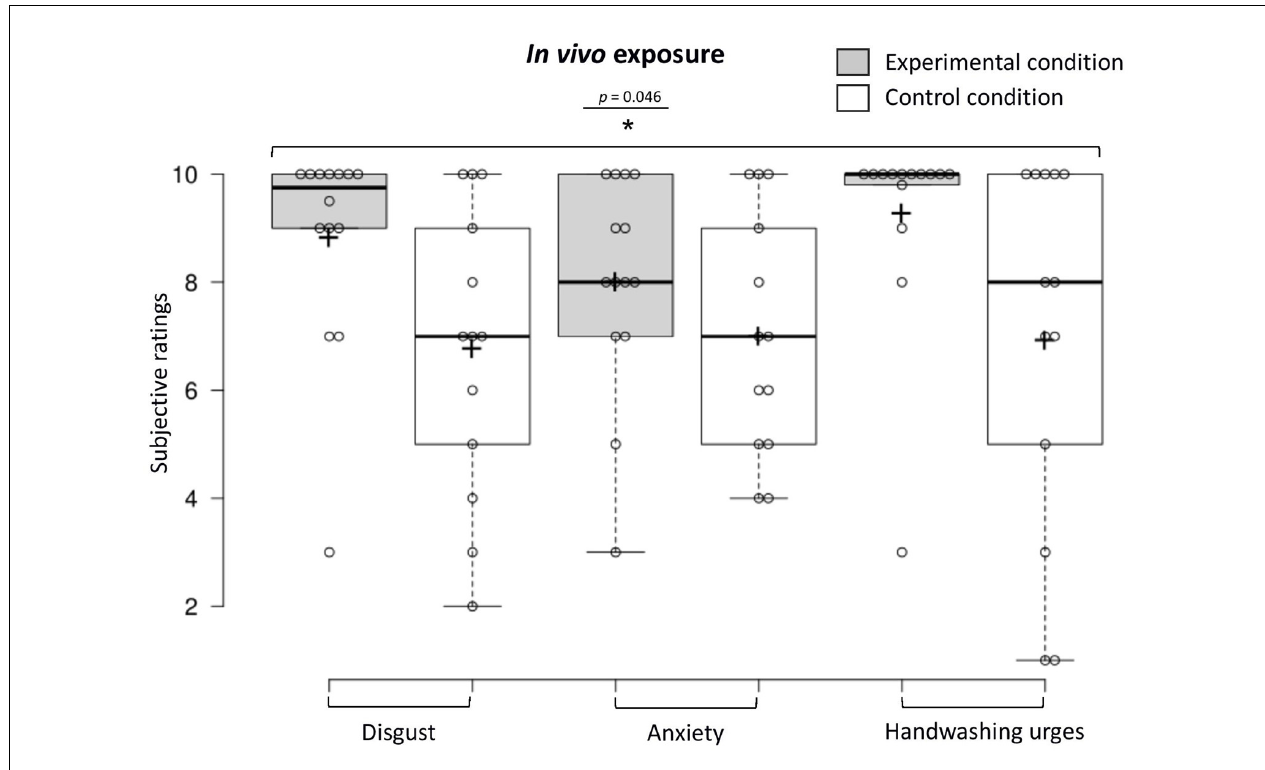
FIGURE 8 | Contamination sensations ratings in the experimental and control condition during the in vivo exposure